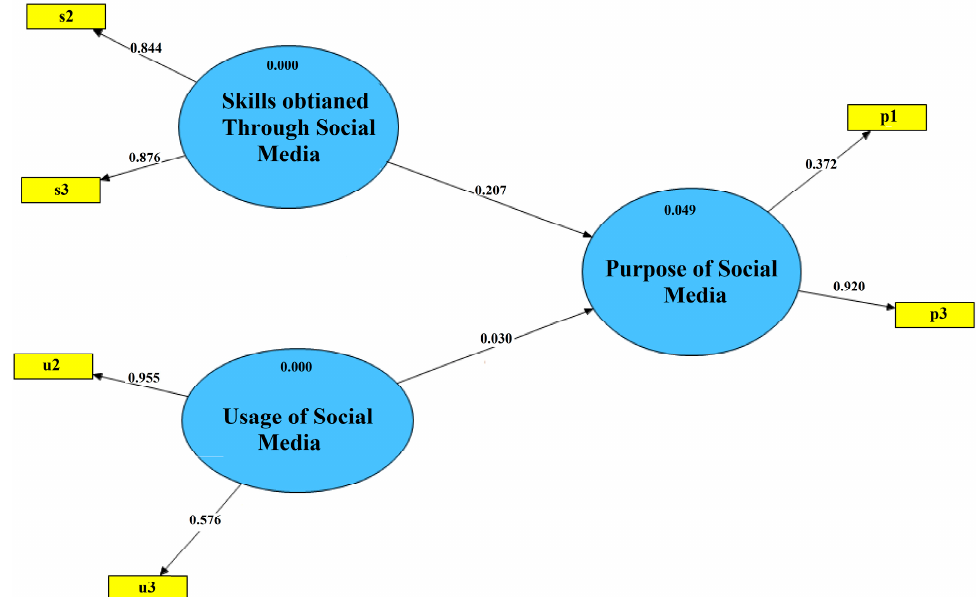
Table 4. Indicators of latent constructs score.